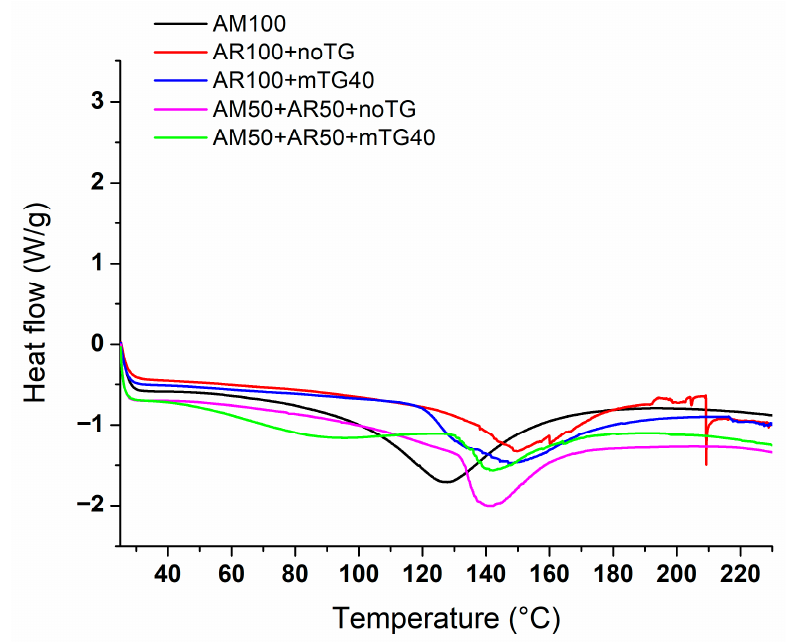
Figure 11. DSC curves of AM100-based films, blended films (APs50-AM50) in the absence and the presence of mTGase, APs100-based films treated or not by the